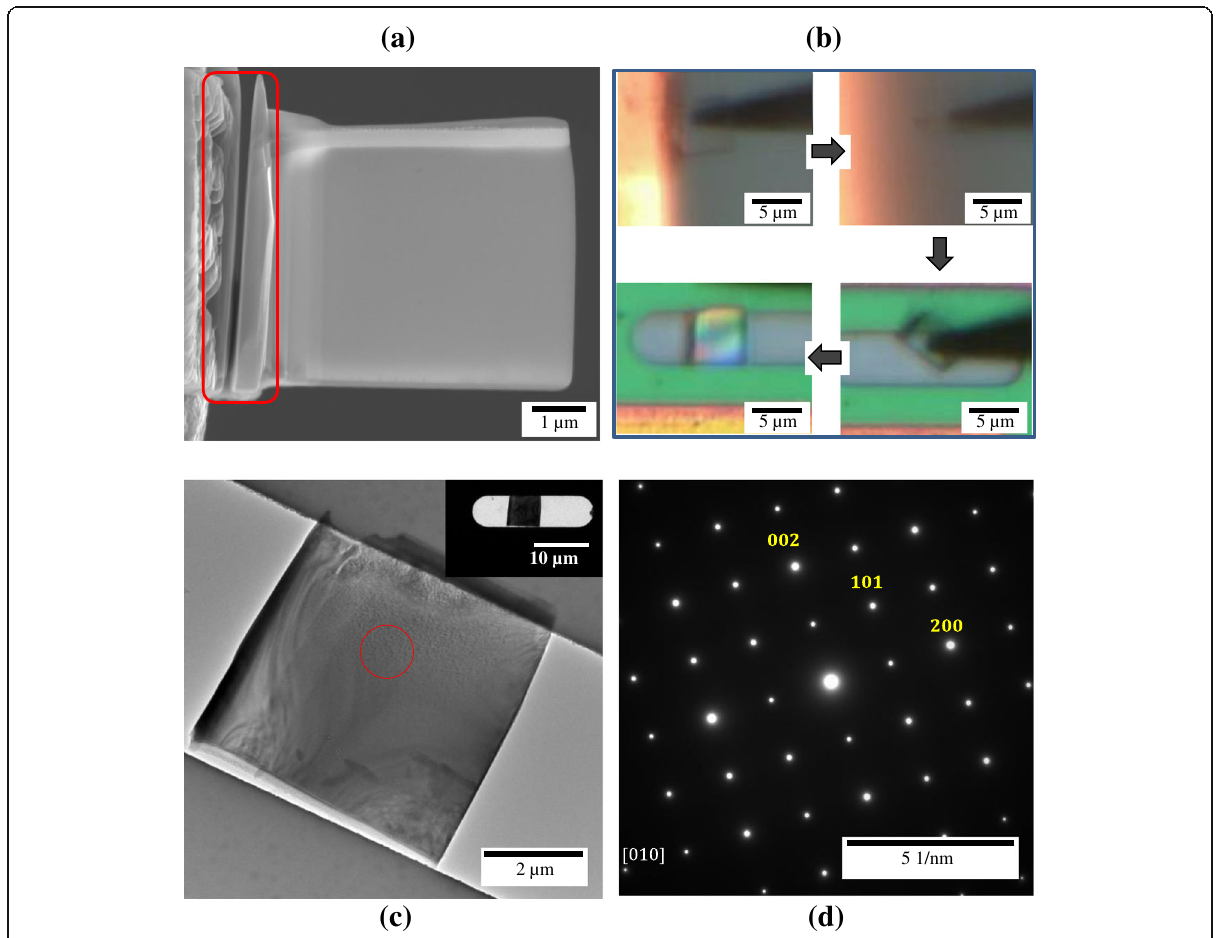
Fig. 5 Transferring process of YAlO 3 pre-milled FIB sample on MEMS window from Cu grid a 53 degree tilted SEM image of YAlO 3 FIB sample. Red squared part shows cut FIB side by 30 kV accelerated Ga + ion. b Transferring process observed by optical microscopy in real time using tip of radius < 1000 nm. c TEM image of transferred YAlO 3 FIB sample on MEMS window. The inset shows low magnification TEM image of sample. d SAED pattern of red circled part in